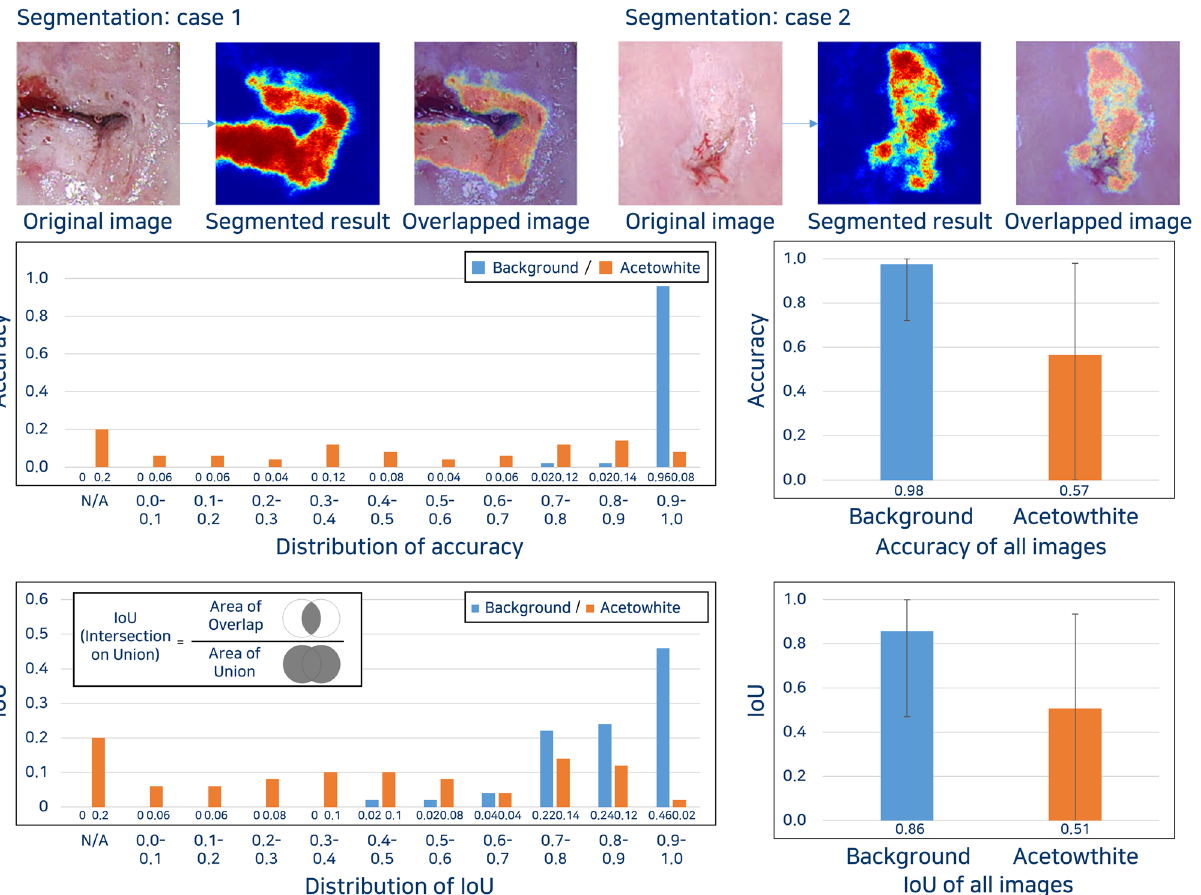
Figure 6. Segmentation performance of SegNet for acetowhite